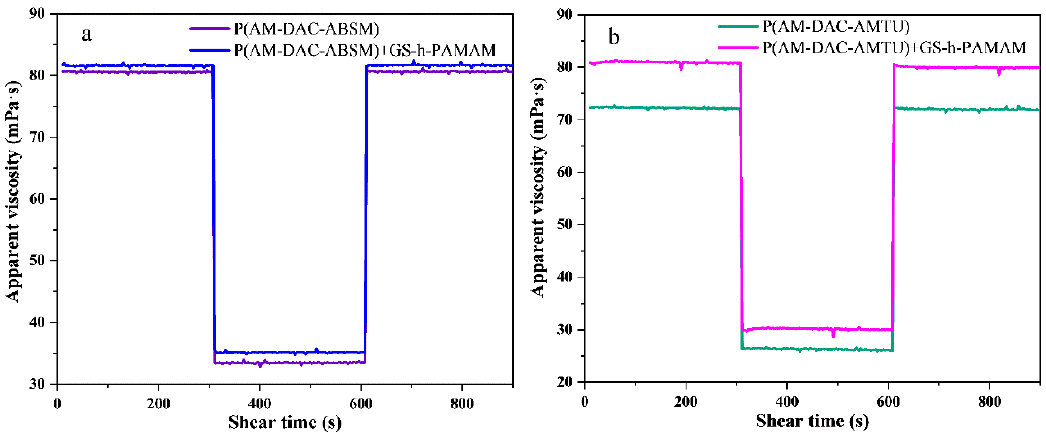
Figure 11. Shear recovery behavior of copolymers and compound systems: ( a ) P(AM-DAC-ABSM) and its supramolecular system; ( b ) P(AM-DAC-AMTU) and its supramolecular system.